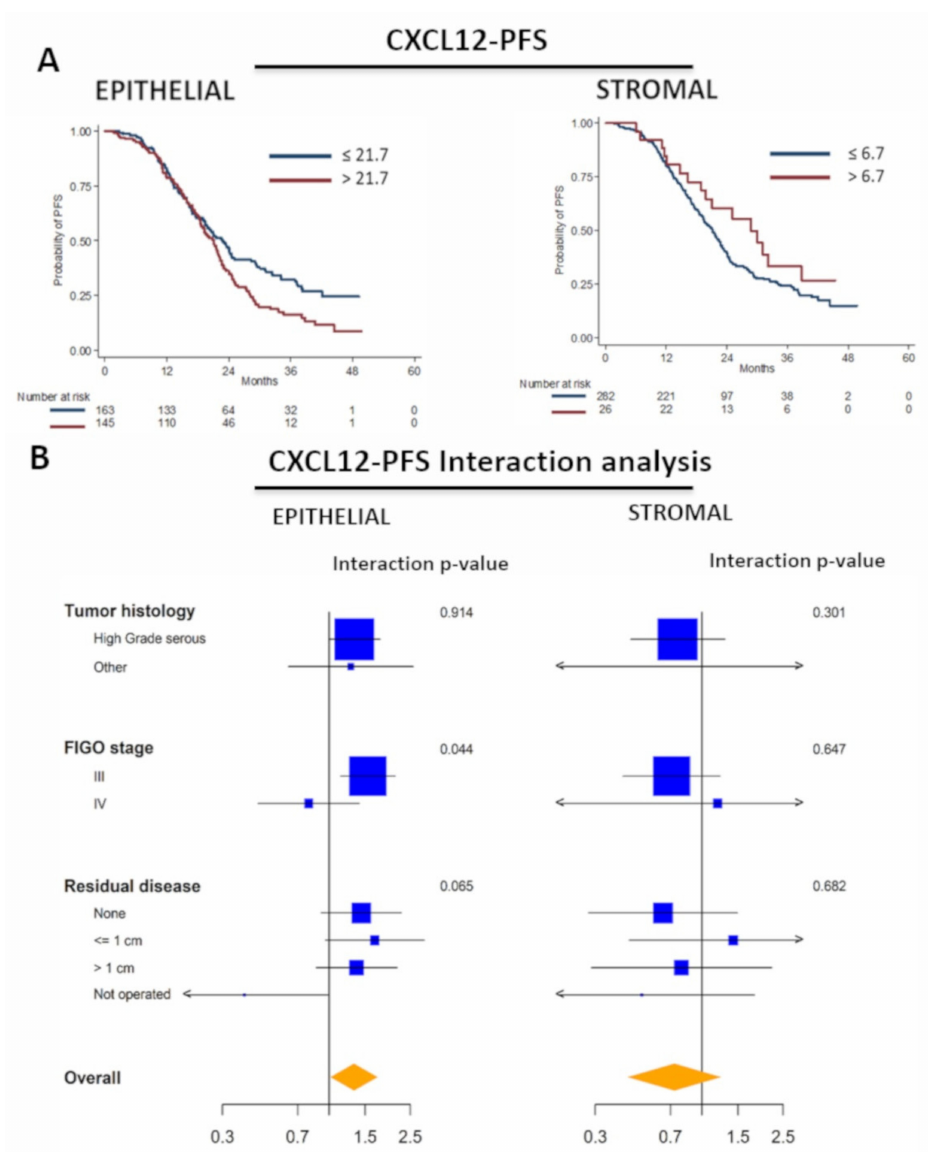
Figure 3. CXCL12 epithelial expression identified risk patients for PFS. PFS and epithelial and stromal CXCL12, Kaplan–Meier curves for identified cut-off on PFS CXCL12 ( A ). Forest plot of hazard ratios (HR) of progression-free survival, and 95% CI, evaluated in different subgroups (Cox proportional hazards model analysis) and interaction comparison between prognostic factor and CXCL12 in epithelial and stromal cells. The x-axis represents the odds ratio on a log scale with the reference vertical line, odds ratios (square) and 95% CI (whiskers) ( B